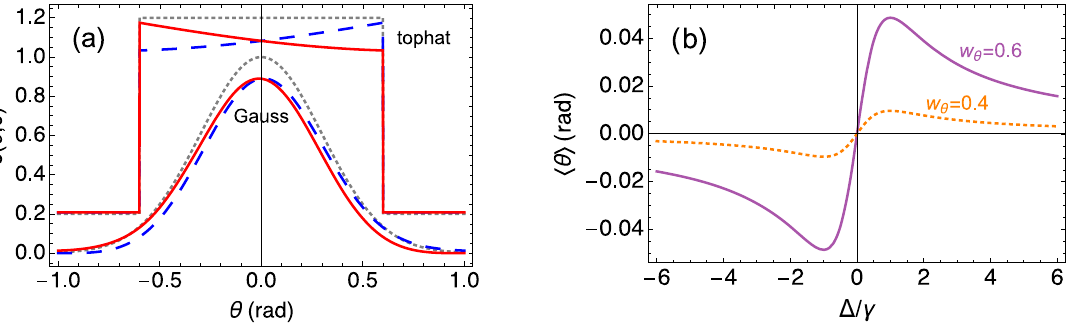
Figure 3: Beam deflection or Magnus effect analogy. (a) Radiant intensities in the plane of the ̂ u + dipole, for a Gaussian incident beam with 𝑤 𝜃 = 0 . 6, and an angular tophat incident beam with r 𝜃 = 0 . 6. The tophat curves have been raised by 0.2 for clarity. In both cases, the gray/dotted curve shows J in ( 𝜃,𝜙 = 0) of the incident beam, normalized to 1 for 𝜃 = 0; red/solid and blue/dashed curves show the outgoing, or total J ( 𝜃, 0), for Δ = − 𝛾 and + 𝛾 , respectively. For clarity, we identify ( 𝜃, 0) ≡ ( − 𝜃,𝜋 ). Curves remain the same upon switching simultaneously the signs of the detuning and the spin of the dipole. (b) The deflection angle of a Gaussian beam as a function of detuning, for two different values of the angular waist 𝑤 𝜃